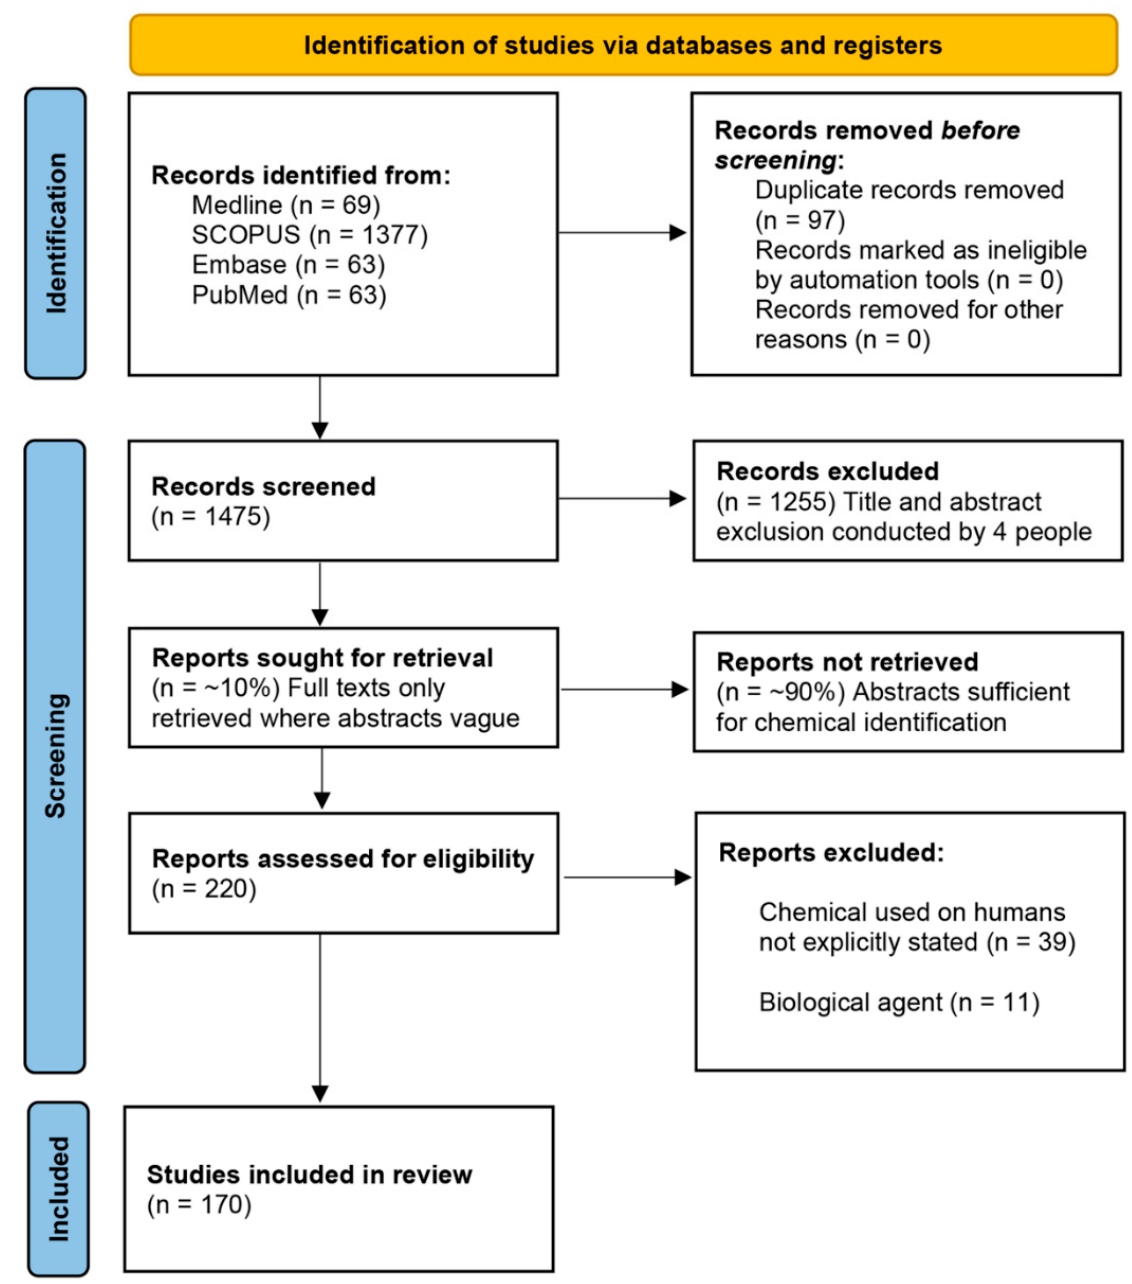
Figure 1. The PRISMA flow diagram showing the stages of screening and exclusion. From 1475 unique papers, 170 included chemicals that were assessed. This figure also shows the distribution of screened